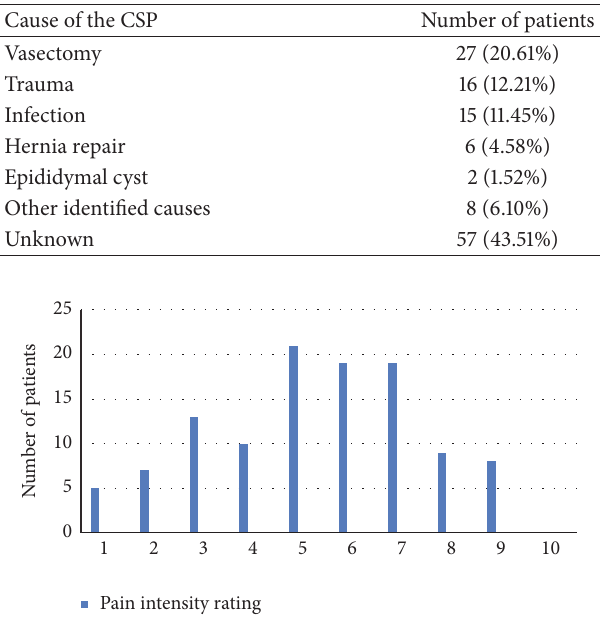
Figure 1: Average pain score in patients with CSP.